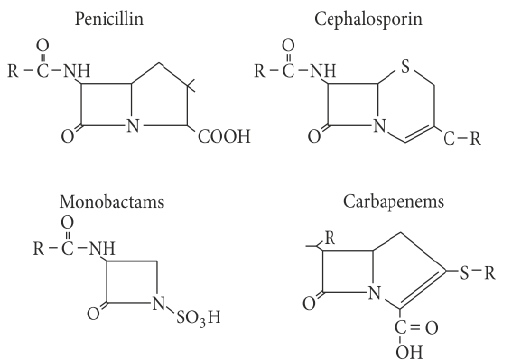
Figure 1. Structure of β -lactam antibiotics, adapted from [12].